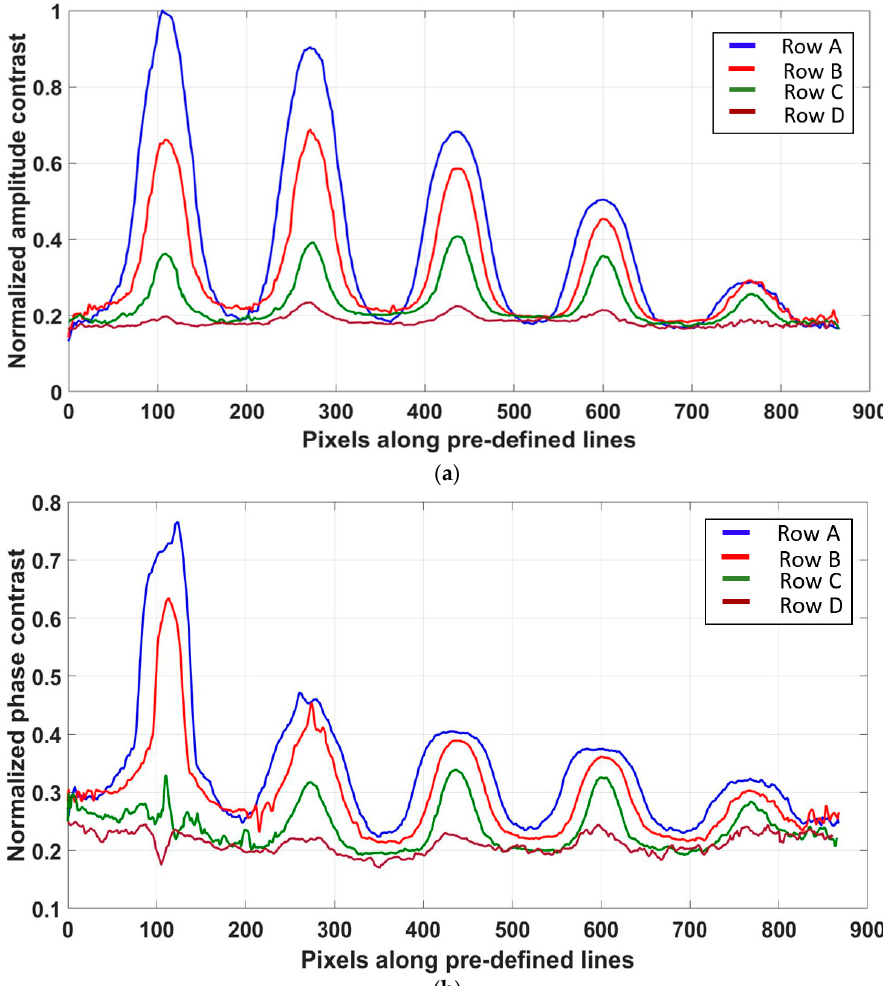
Figure 12. ( a ) Normalized amplitude value and ( b ) normalized phase value distributions of the defects where the thermograms were obtained during cooling and heating, respectively.